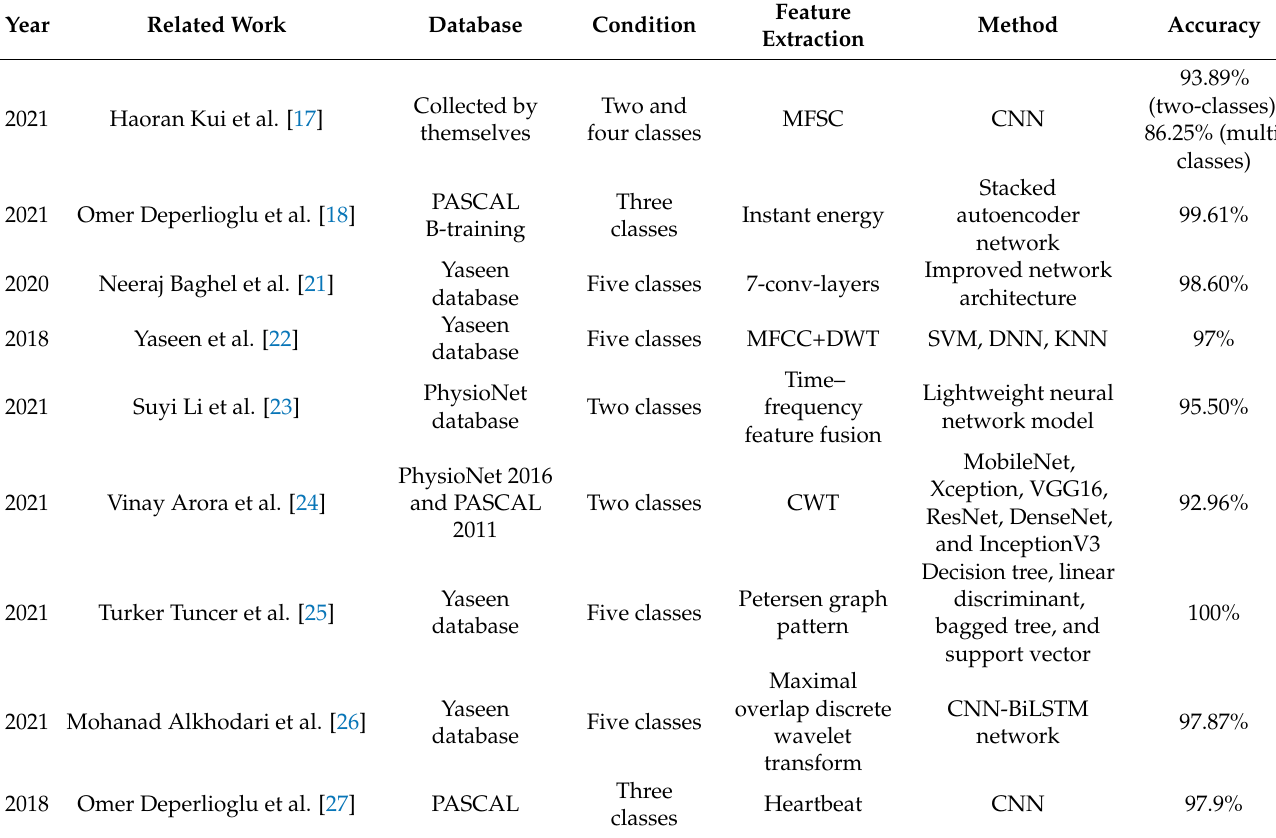
Table 1. A comparative performance of existing work for the cardiac disease